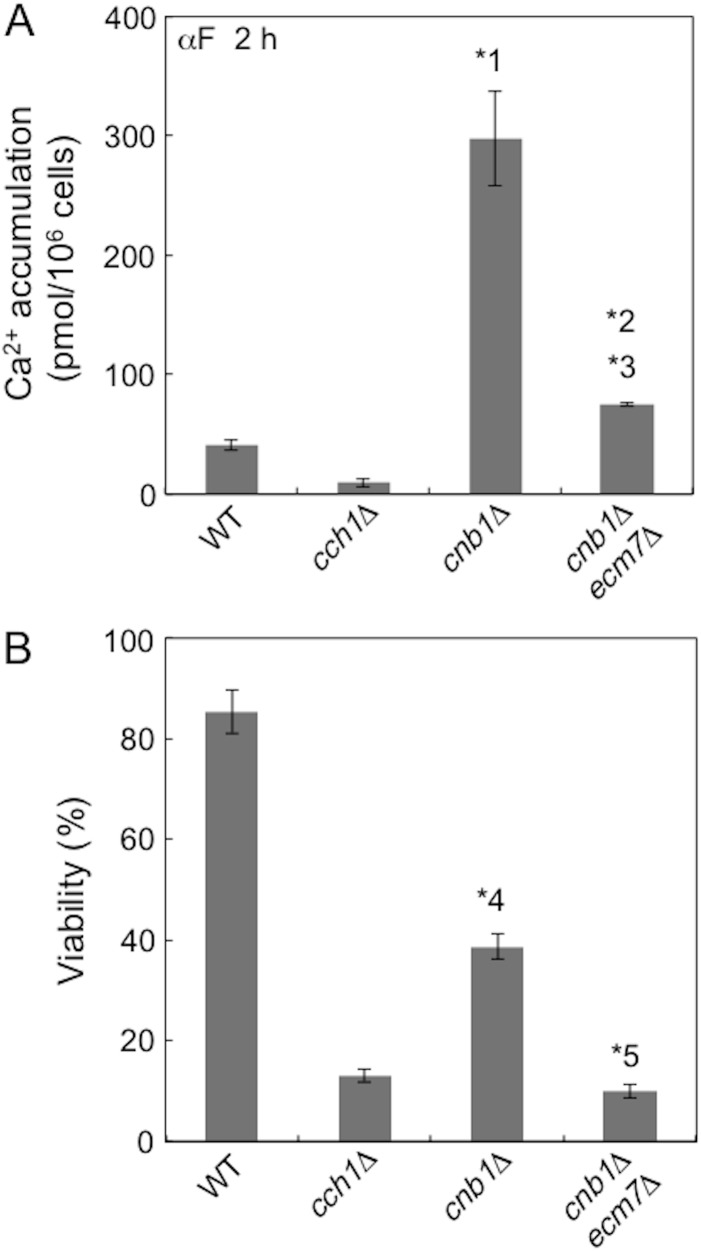
The deletion of ECM7 results in a marked decrease in Ca2+ accumulation and viability in cnb1Δ cells.Experimental conditions and procedures were the same as those described in the legend to Fig 2. *1, p < 0.05 (WT vs. cnb1Δ); *2, p < 0.05 (cnb1Δ vs. cnb1Δ ecm7Δ); *3, p < 0.05 (WT vs. cnb1Δ ecm7Δ); *4, p < 0.05 (WT vs. cnb1Δ); *5, p < 0.05 (cch1Δ vs. cnb1Δ ecm7Δ). Data are the mean ± SD of three independent experiments.